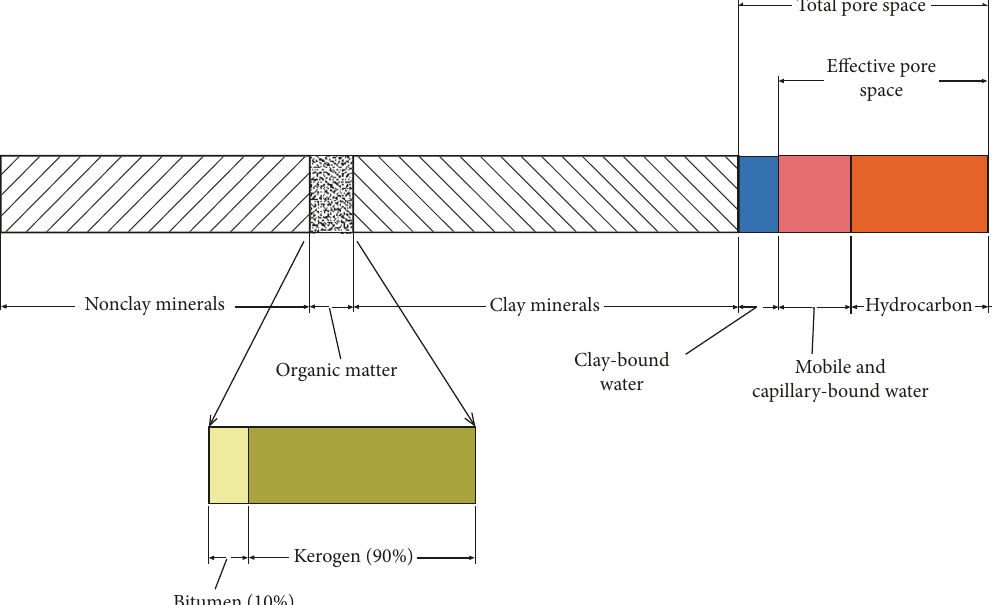
Figure 6: Schematic representation of the composition of typical shale formation, adapted from Prasad et al. [4].